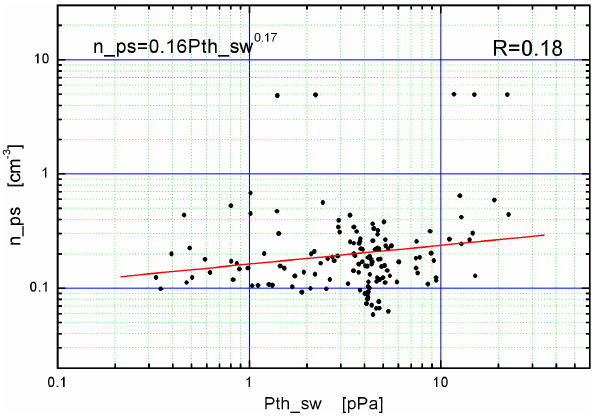
Fig. 5. The relationship between the dynamic pressure of the solar wind and the ion thermal pressure in the plasma